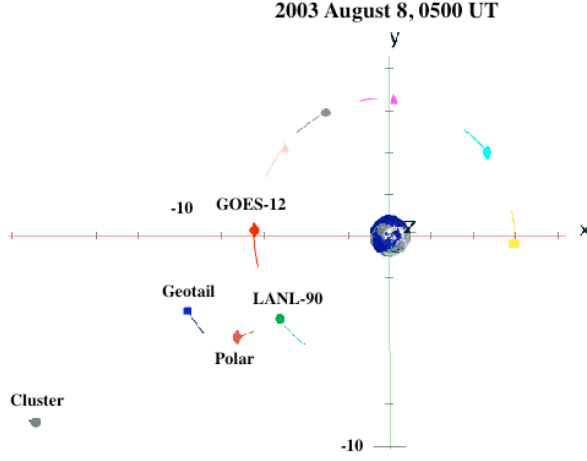
Fig. 3. The location of several satellites in the magnetotail during Figure 3 this substorm activity interval. The length of the trace associated with each satellite symbol represents the distance traveled by the satellite in 1-h interval after the epoch time of 05:00 UT on 8 August